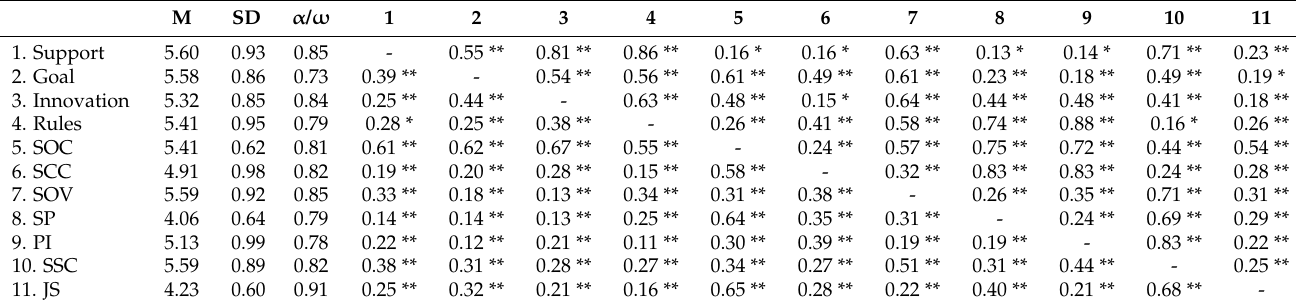
Table 5. Descriptive statistics and correlations between study variables at the individual and